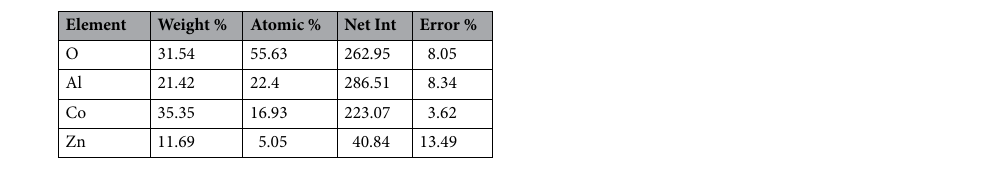
Table 3. EDX analysis for Zn Co/Al 2 O 4 catalyst.